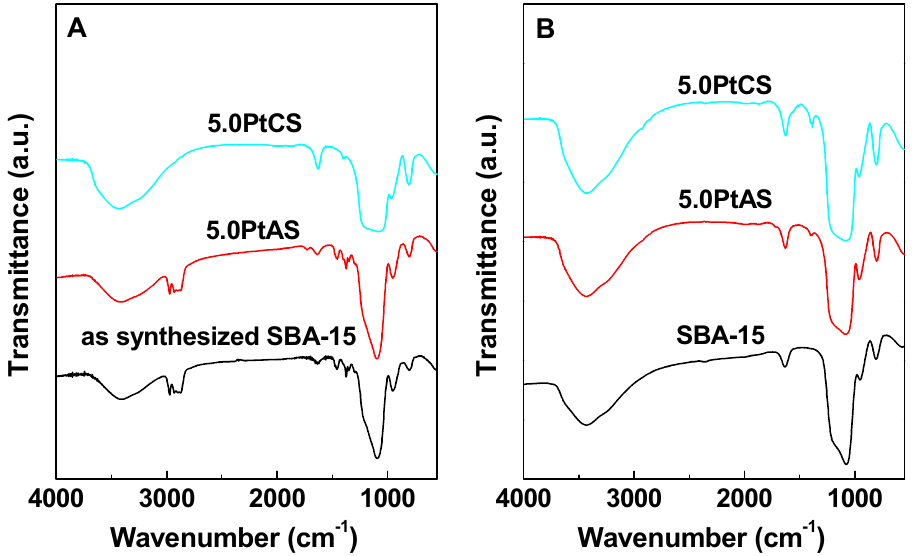
Figure 7. IR spectra of SBA-15, 5.0PtAS and 5.0PtCS samples ( A ) before and ( B ) after calcination.